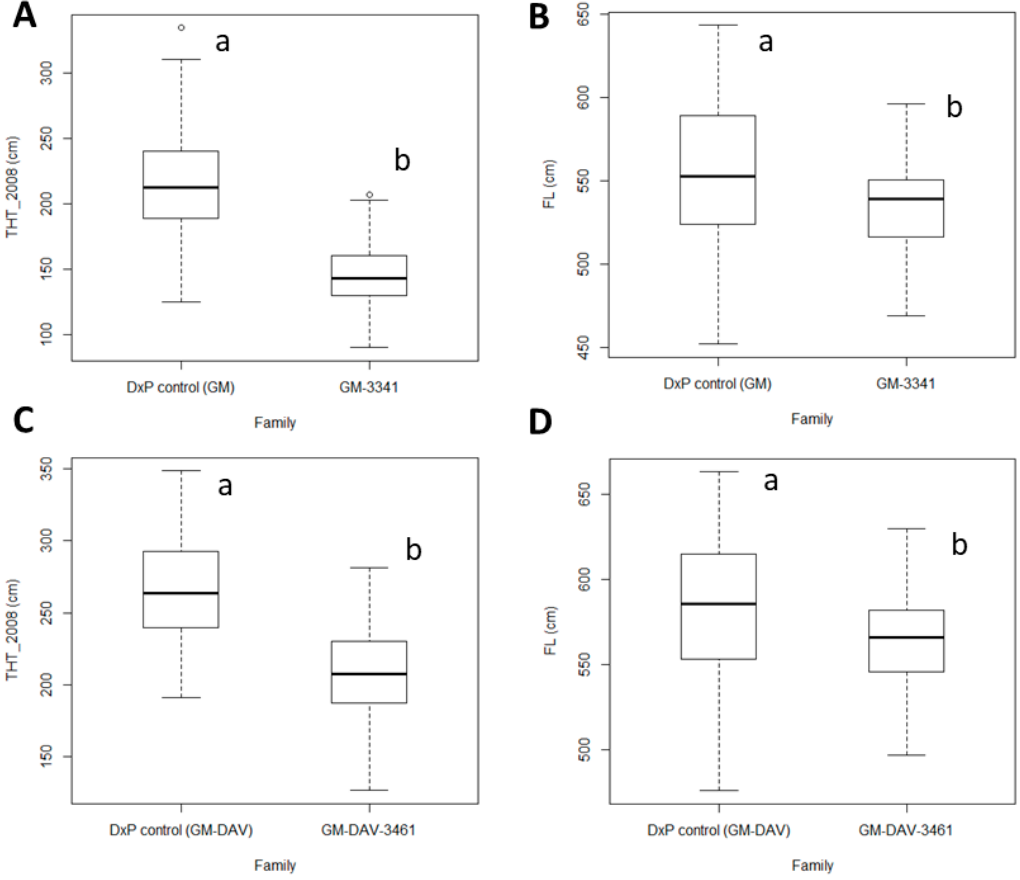
Figure 1. The boxplots represent median values, percentile 25–75 for trunk height measured in 2008 (THT_2008) and frond length (FL) between families. ( A ) THT_2008 comparison between the DxP control and the GM-3341 family in the PT132 trial in the East Estate; ( B ) FL comparison between the DxP control and the GM-3341 family in the PT132 trial in the East Estate; ( C ) THT_2008 comparison between the DxP control and the GM-DAV-3461 family in PT138 in the North Estate; ( D ) FL comparison between the DxP control and the GM-DAV-3461 family in PT138 in the North Estate. The trait comparisons were analyzed based on two-sample T test at the p = 0.05 threshold.